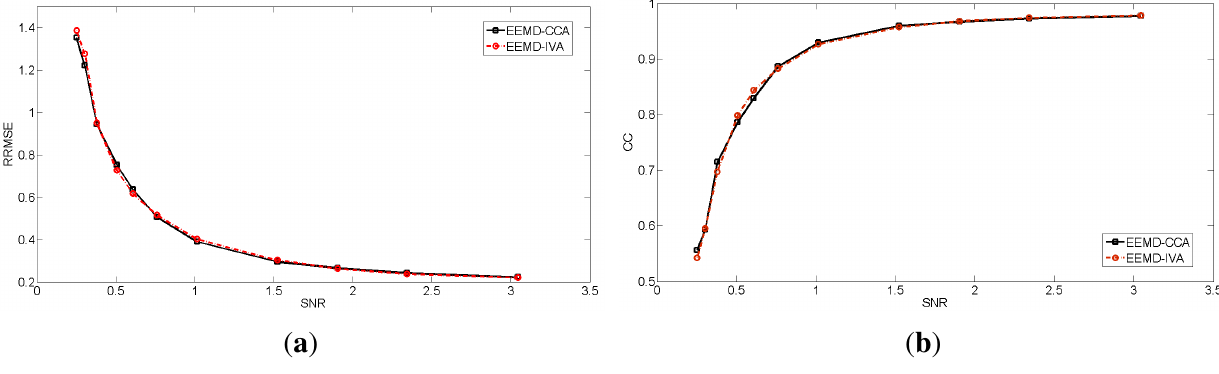
Figure 5. The step-wise results of the EEMD-CCA method: ( a ) the intrinsic mode function (IMF) components after applying EEMD to the single-channel EEG x ( ε = 1 . 5 ); ( b ) the canonical variates after using CCA; ( c ) the reconstructed EEG signal ˆx after muscular artifact cancellation; ( d ) the amplified version of ˆx compared with the original EEG x